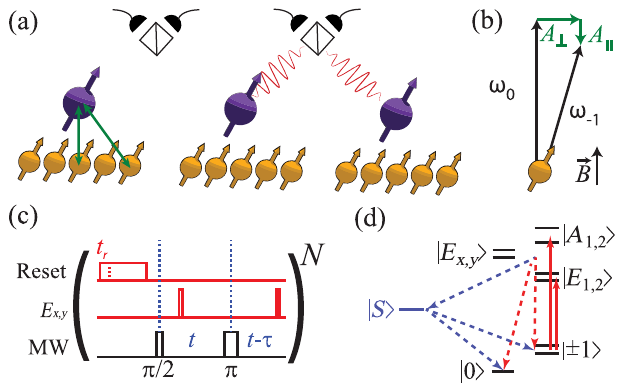
FIG. 1. (a) Layered quantum-network architecture. Individual electronic spins (purple spin symbols) are entangled probabilisti- cally over large distances using photons (red curly lines). Each electronic spin is hyperfine coupled to a quantum register of surrounding nuclear spins (yellow) that can be deterministi- cally controlled (green arrows). (b) Electron-nuclear coupling. ~ B The nuclear spins precess in an external magnetic field . The precession axis and frequency, ω 0 or ω − 1 (black vectors), depend on the state of the electronic spin, j 0 i or j − 1 i , via the hyperfine interaction with parallel component A ∥ and perpendicular com- ponent A ⊥ (green vectors). (c) Experimental sequence to generate entanglement between remote NV electronic spins [20]. By optical pumping on the “ reset ” transition, the spin is initialized in j 0 i at time t r . Subsequently, a spin superposition state is created via a microwave π = 2 pulse. Spin-photon entanglement is then generated via two optical excitations, separated by a microwave π pulse that inverts the spin state j 0 i ↔ j − 1 i . (d) NV electronic orbital and spin level scheme at cryogenic temperature. The ground states j 0 i ( j (cid:2) 1 i ) are optically coupled to the excited states j E x;y i ( j E 1 ; 2 i and j A 1 ; 2 i , red arrows), respectively. These states decay either directly (red dashed arrows) or via the metastable spin singlet states j S i (blue dashed arrows) to one of the ground states.